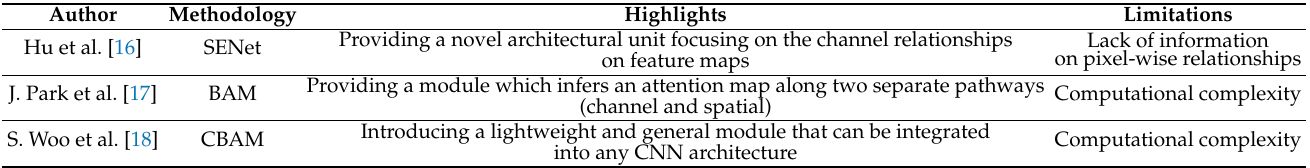
Table 3. A summary table of the attention